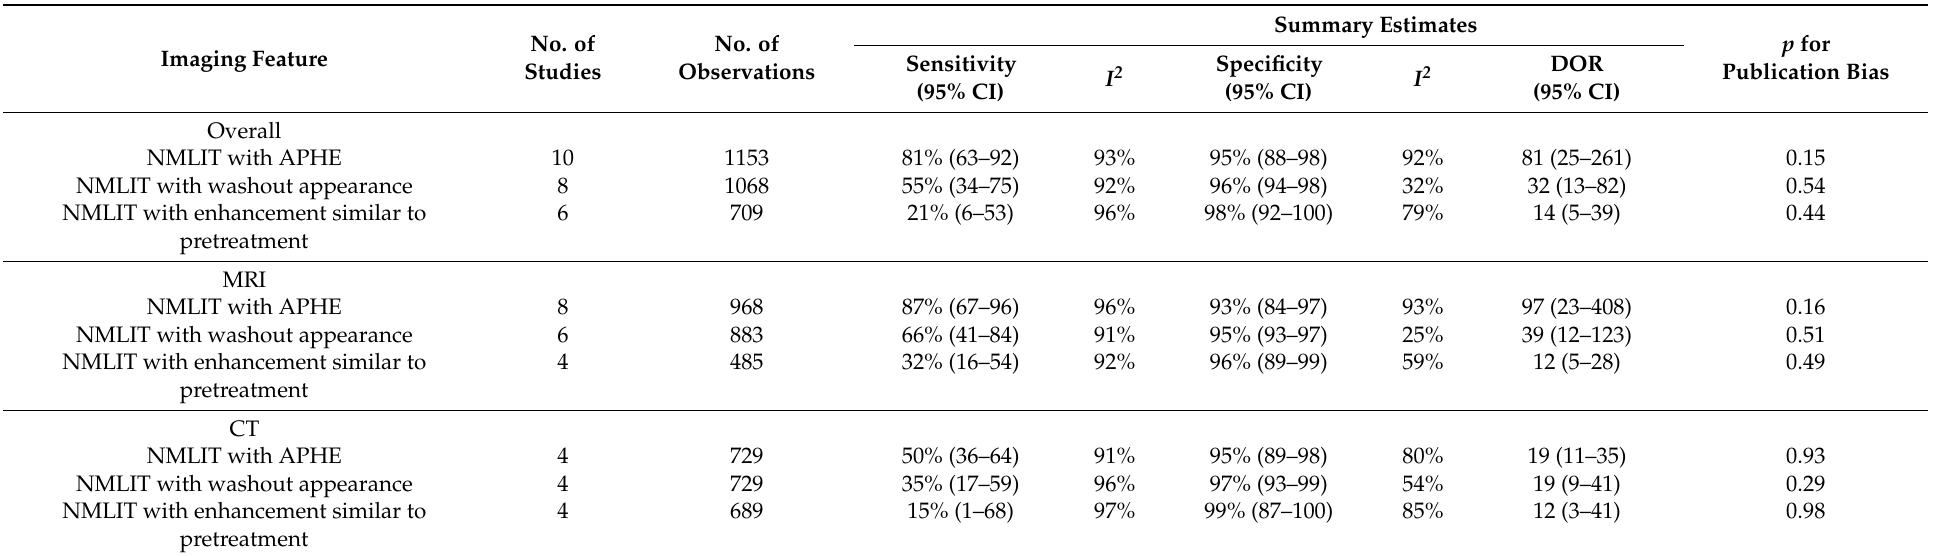
Table 2. Meta-analytic summary estimates of imaging features for LR-TR viable